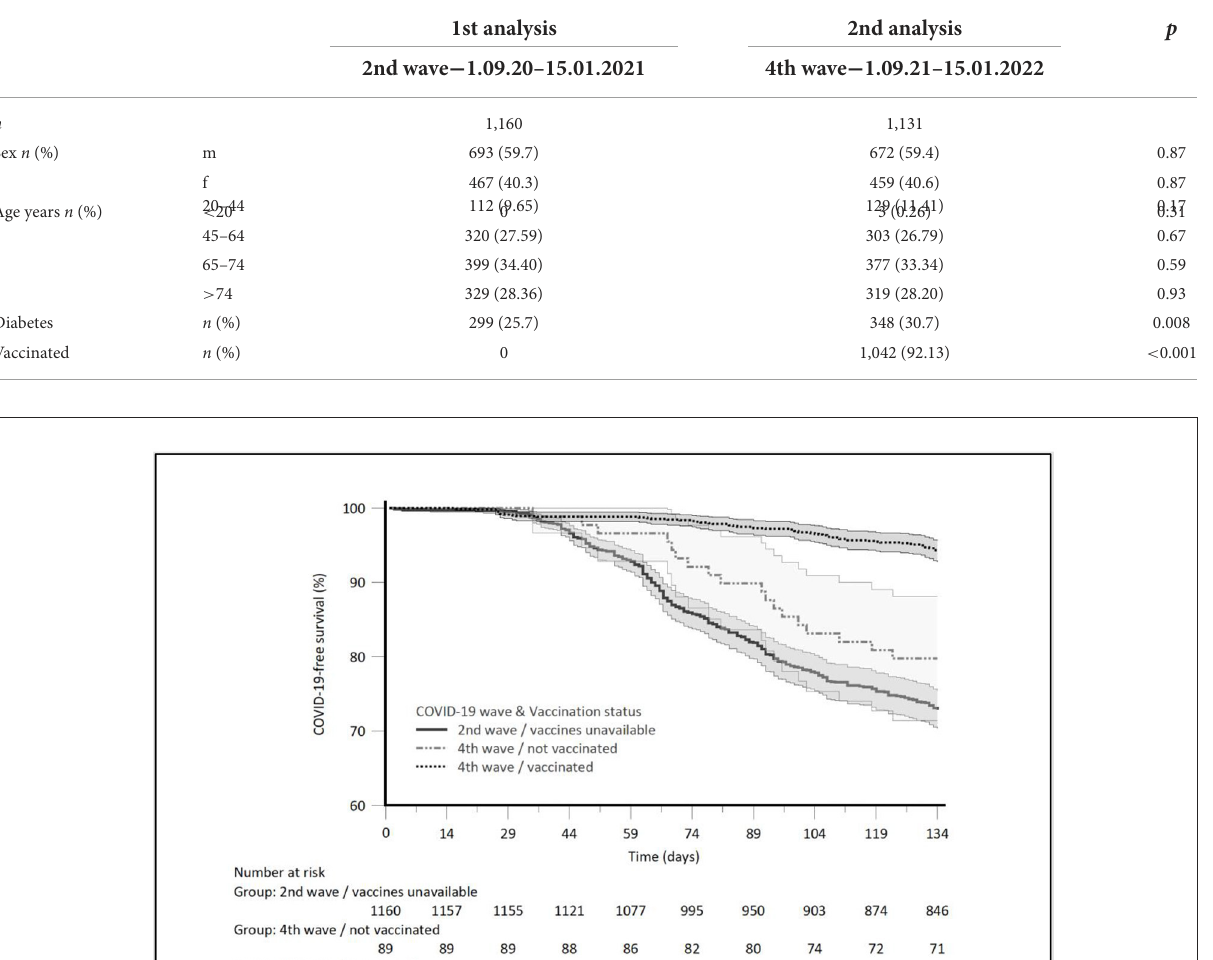
TABLE 1 Characteristic of two cohorts analyzed during the second and fourth pandemic wave.